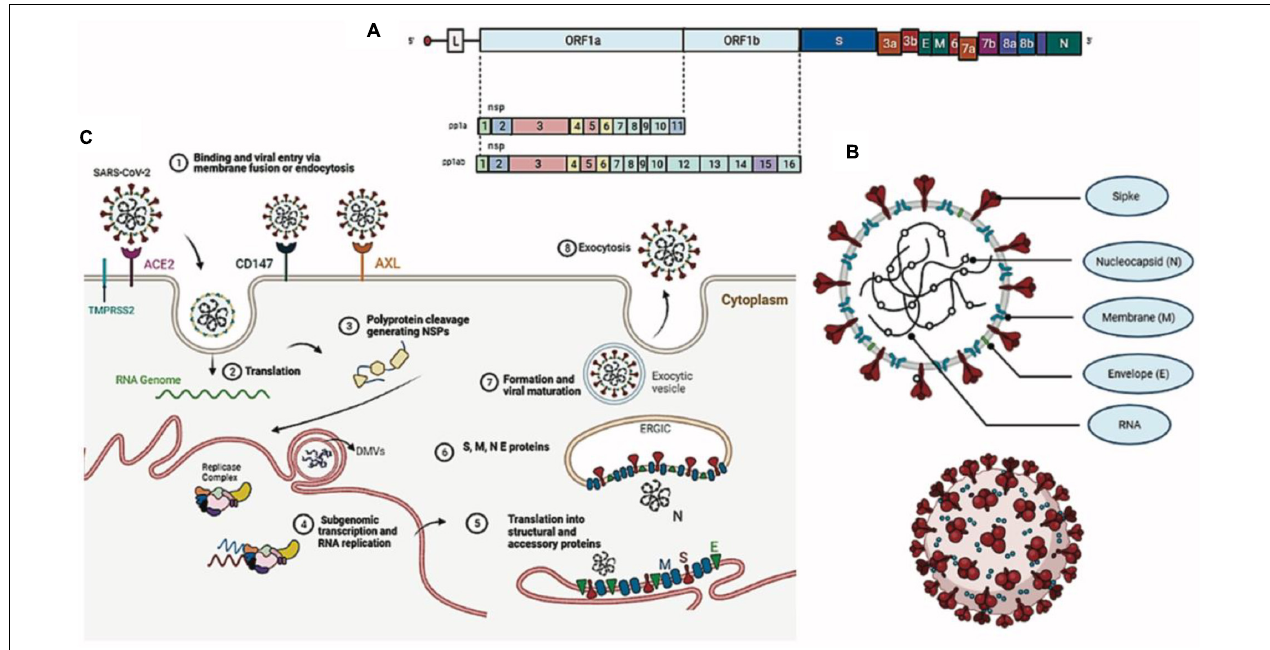
FIGURE 1 | Morphological structure, genome, and replication of SARS-CoV-2. (A) Viral genome. (B) Viral particle. (C) SARS-CoV-2 replication cycle. TABLE 1 | SARS-CoV-2 structural proteins and their roles in the viral replication cycle. Protein Function Spike